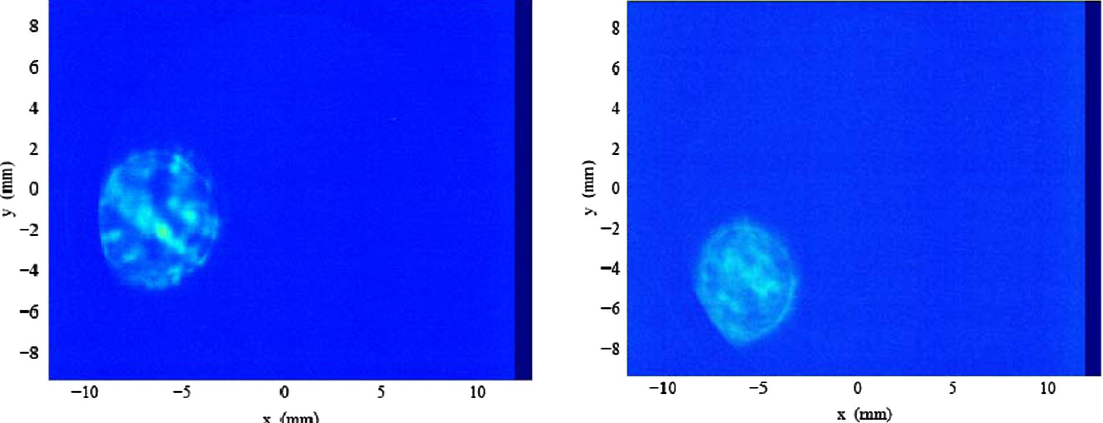
FIG. 8. The QE emission improvement: taken immediately after the laser cleaning (left) and a few months following the cleaning (right). The image was taken at a screen located about 1.43 m downstream of the gun, with a 20 pC bunch charge.